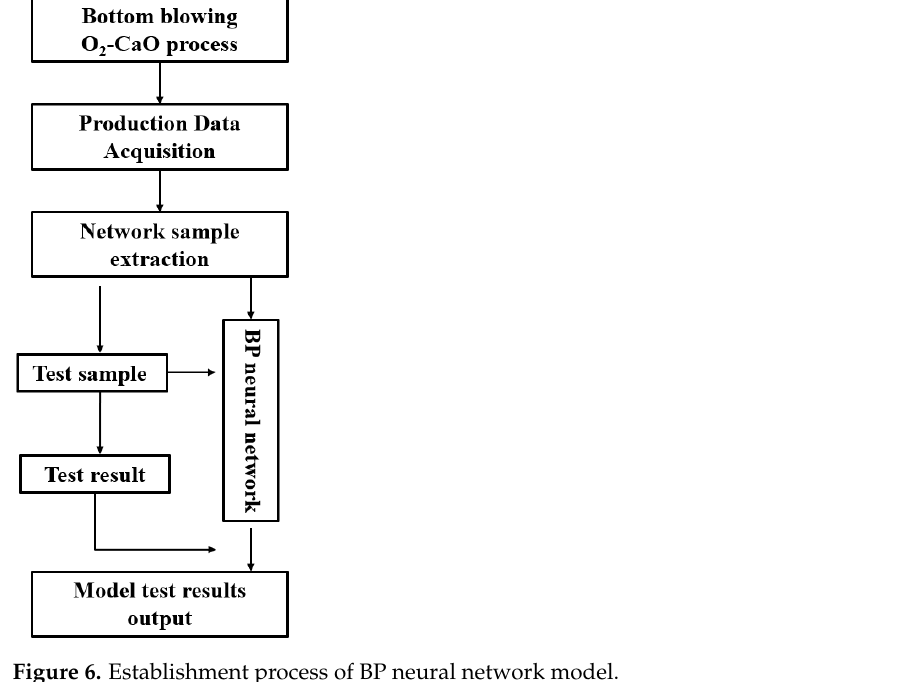
Figure 6. Establishment process of BP neural network model.